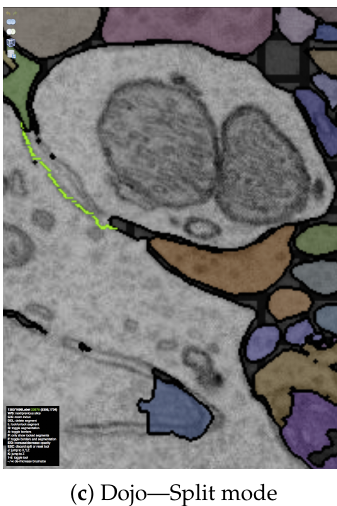
Figure 13. Three steps in the use case of splitting connected cell bodies. In ( a ), a single green label includes two large cell bodies. Therefore, the one label contains the joined reconstruction of two neurons. A neural process runs from a broad base off the lower cell body. While the projection correctly passes narrowly behind one branch of the upper neuron, the tip of process mistakenly merges with the surface of the upper soma at a small point shown in red. In ( b ), the dojo editor displays the false merge between the large upper soma and the small neural process (upper right). Using the same segmentation available to the 3D view, both neurons display as parts of one green segment. In ( c ), a detailed view shows the same false merge with the segmentation label removed. The membrane between the large soma and the small projection displays as a darkened band in the EM image section. The green line, drawn by the user, allows the separation of the falsely merged